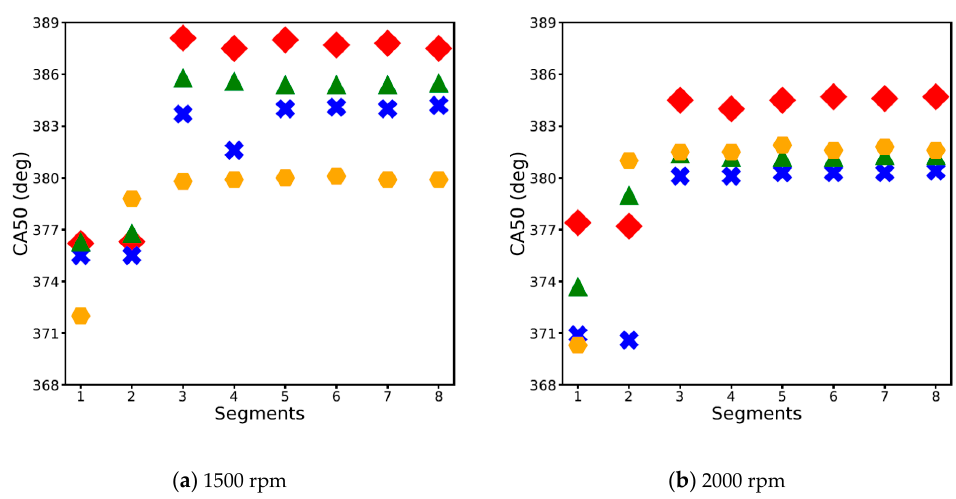
Figure 14. CA50 at all loads in each stage at ( a ) 1500 rpm and ( b ) 2000 rpm. The red thick diamond represents 100% load, the blue thick cross 50% load, the green triangle 75% load and the orange hexagon 25% load.